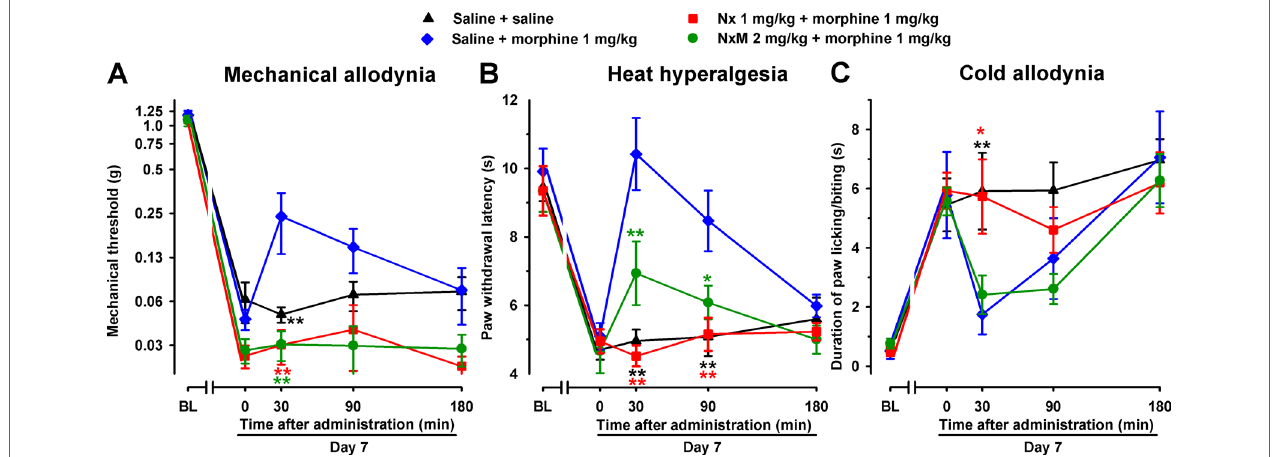
FIGURE 9 | Differential ability of Nx and NxM to reverse the effects of morphine on mechanical allodynia, heat hyperalgesia, and cold allodynia in female WT mice with SNI 7 days after surgery. Mechanical allodynia (A) , heat hyperalgesia (B) , and cold allodynia (C) were evaluated 1 day before (baseline, BL) and 7 days (day 7) after surgery in the paw ipsilateral to the surgery. On day 7 the responses to test stimuli were recorded immediately before (time 0) and at several times (30, 90, and 180 min) after injections of the drugs (morphine and opioid antagonists) or saline. Each point and vertical line represent the mean ± SEM of the values obtained in 8–14 animals. Statistically significant differences in comparison to the saline+morphine group: * P < 0.05; ** P < 0.01 (two-way repeated-measures ANOVA followed by Bonferroni test).